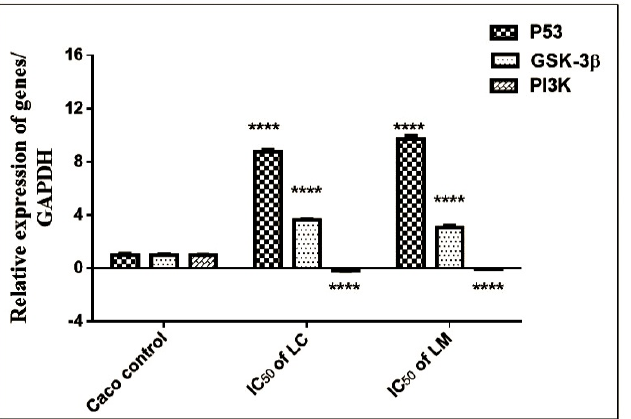
Figure 7. Relative expression of p53, GSK-3 β , and PI3K in Caco cells. Results were expressed as mean ± SE, ( n = 3). **** p < 0.0001 is considered significant compared to the Caco control untreated cells.